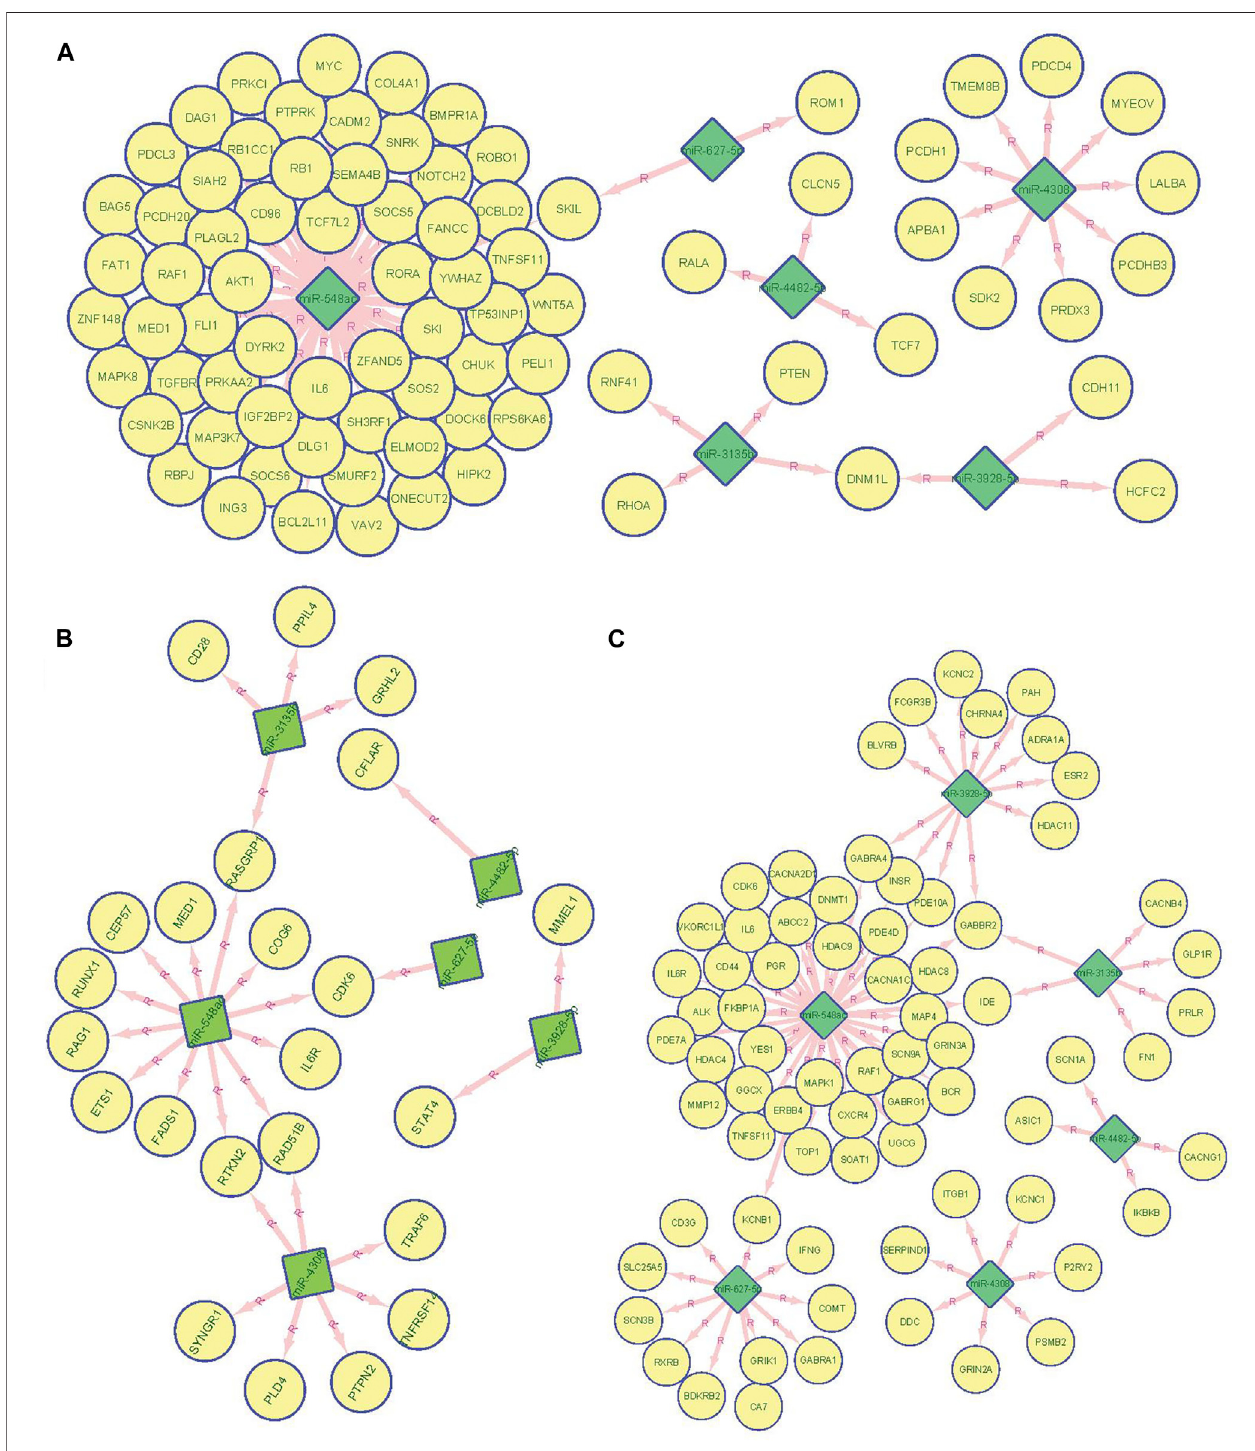
FIGURE3| miRNAtargetanalysisandtargetdistributioninGWASsigni fi cantgenes,immunegenes,andFDAdrugtargetgenes. (A) .Networkconnectionbetween the top 6 miRNA predicted regulatory targets and previous GWAS identi fi ed 123 RA associated genes. (B) . Network connection between the top 6 miRNA predicted regulatorytargetsand4,723InnateDBcollectedimmunegenes. (C) Networkconnectionbetweenthetop6miRNApredicted regulatorytargets and672FDAapproved drug target genes. miRNA was labeled as diamond fi lled with green color and gene were as a circle fi lled with yellow color.